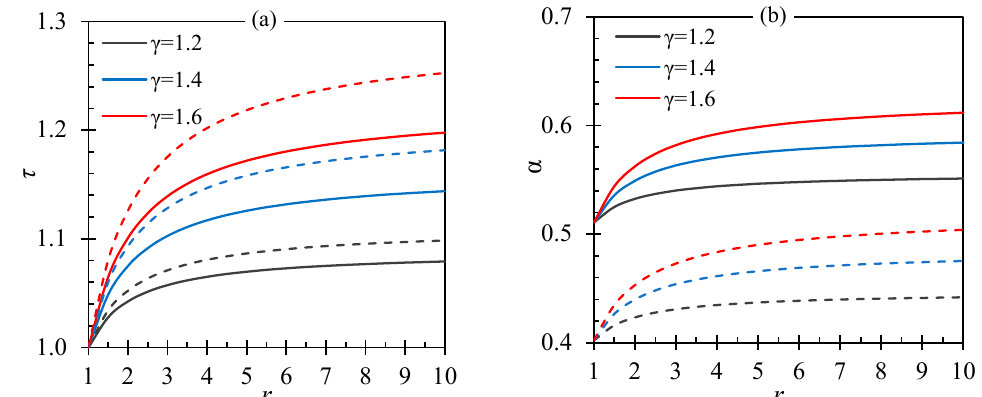
Figure 7. Dimensionless temperature of the driving gas at the end of the compression stroke ( a ) and efficiency of the driving gas use ( b ) as a function of the driver pressure ratio and different γ ; γ c = 1.4, r c = 5; solid lines—adiabatic compression, dashed lines—isothermal